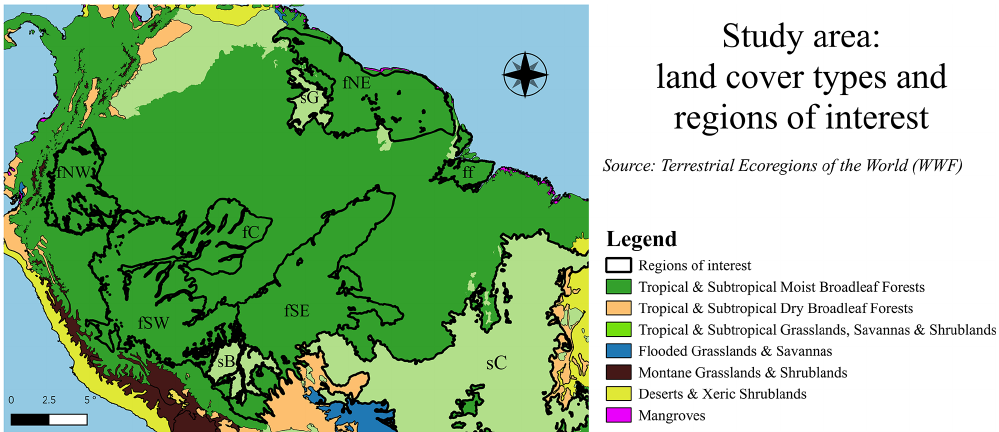
Figure 1. Study area. The map is colored by biome, and nine ecoregions of interest are highlighted based on the dataset of Olson et al. (2001). The six forest ecoregions of interest are the Napo moist forests (fNW), Guianan moist forests (fNE), Southwest Amazon moist forests (fSW), Madeira–Tapajós moist forests (fSE), Juruá–Purus moist forests (fC), and the Marajó várzea flooded forests (ff). The three savanna ecoregions of interest are the Cerrado (sC), Guianan savanna (sG), and Beni savanna (sB).